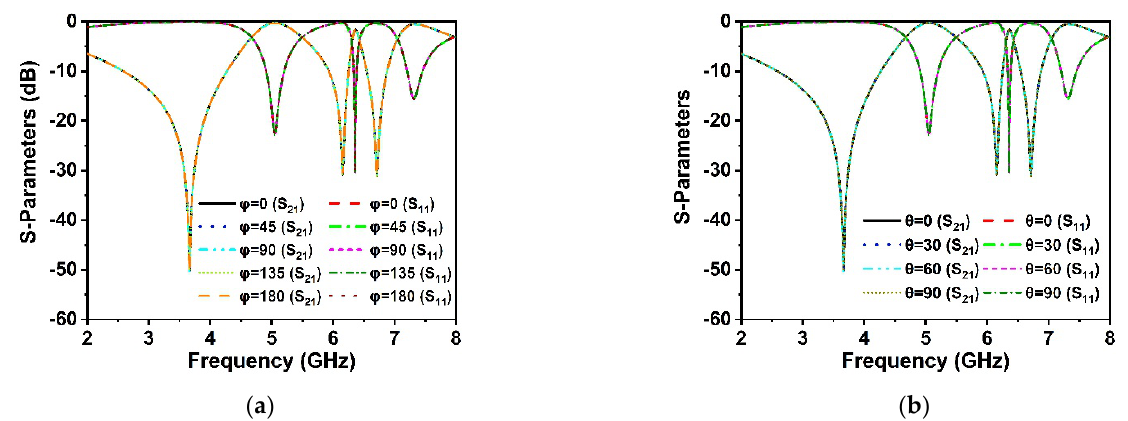
Figure 9. Polarization-independent performance of the proposed unit cell for ( a ) normal incidence and ( b ) oblique incidence.